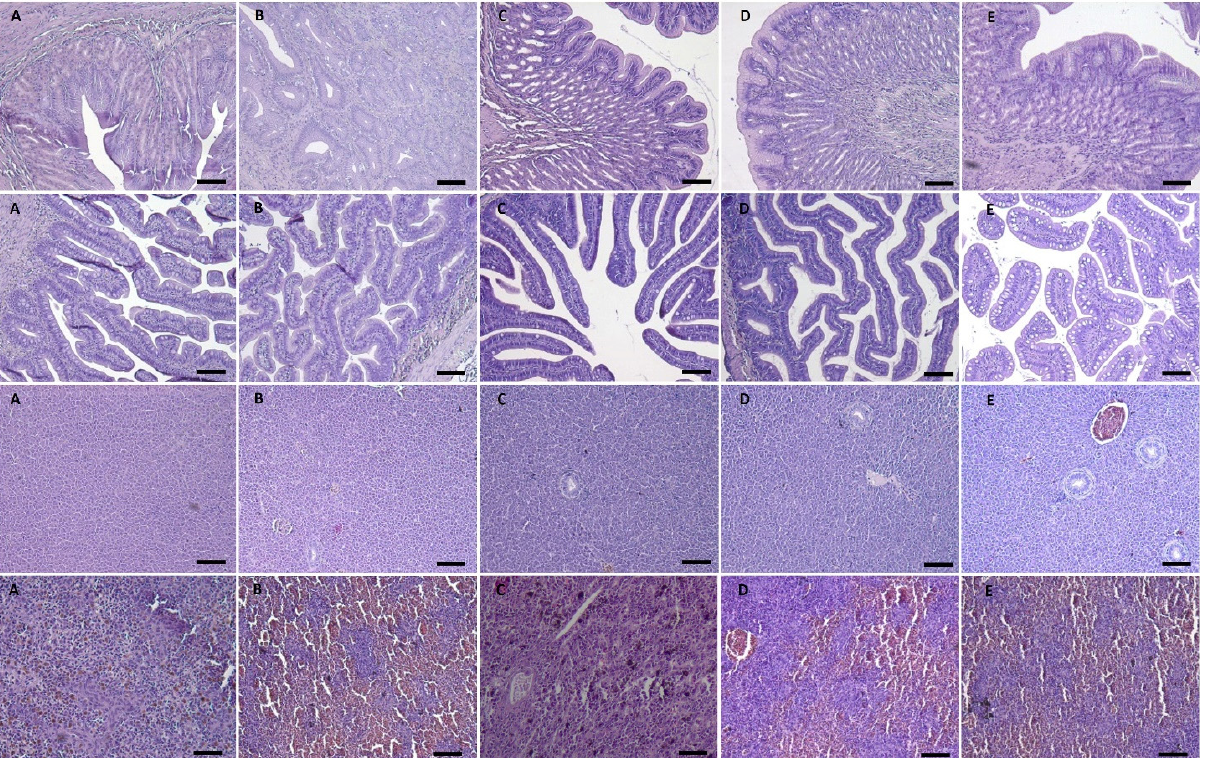
Figure 12. Head kidney ( first line ) and posterior kidney ( second line ) of salmon at different sampling times. ( A ) Control. ( B ) 1 week after exposure. ( C ) 2 weeks after exposure. ( D ) 3 weeks after exposure. ( E ) 4 weeks after exposure. Scale bar: 100 µm.